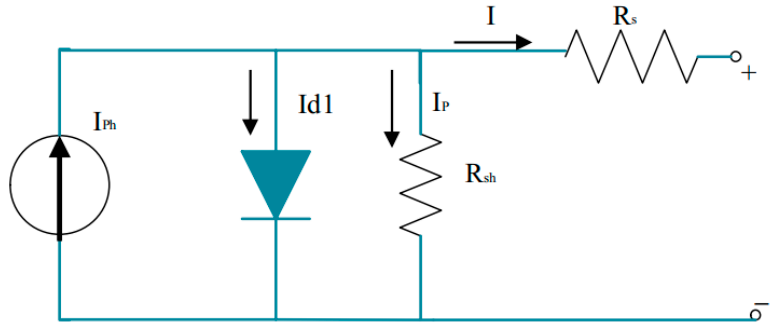
Figure 3. Equivalent circuit of PV cell.